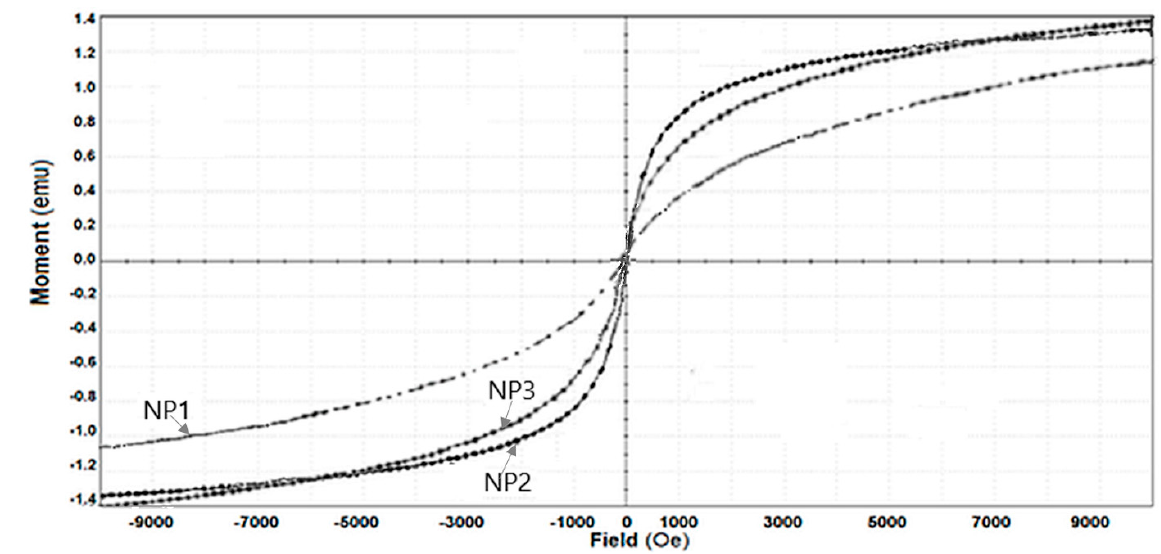
Figure 5. The magnetization diagrams for NP 1 , NP 2 , and NP 3 .